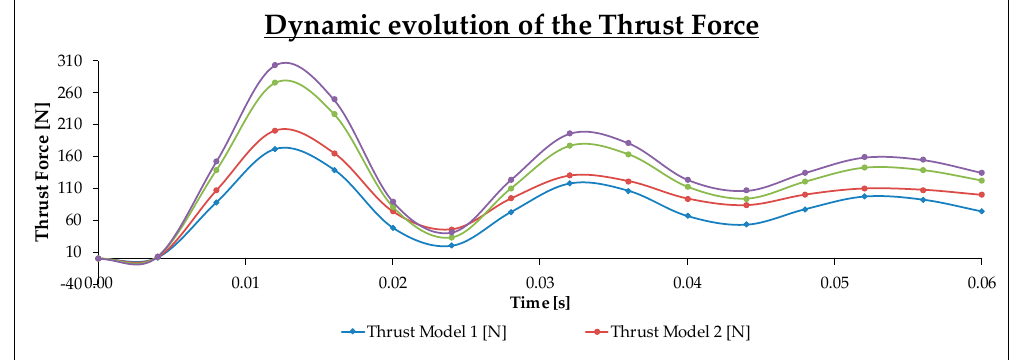
Figure 26. Dynamic evolution of the thrust force in each model.